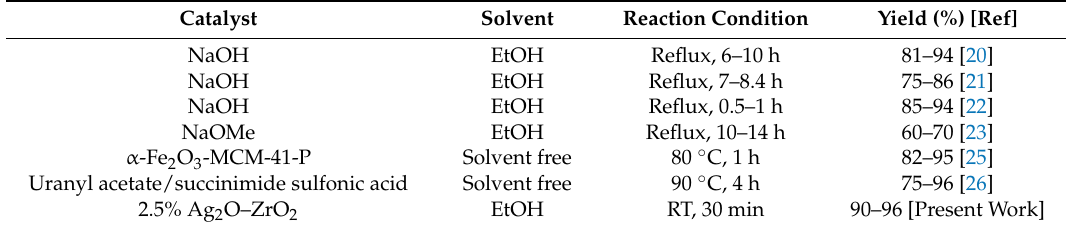
Table 5. A comparison table with various other catalysts for synthesizing pyrimidine derivatives.